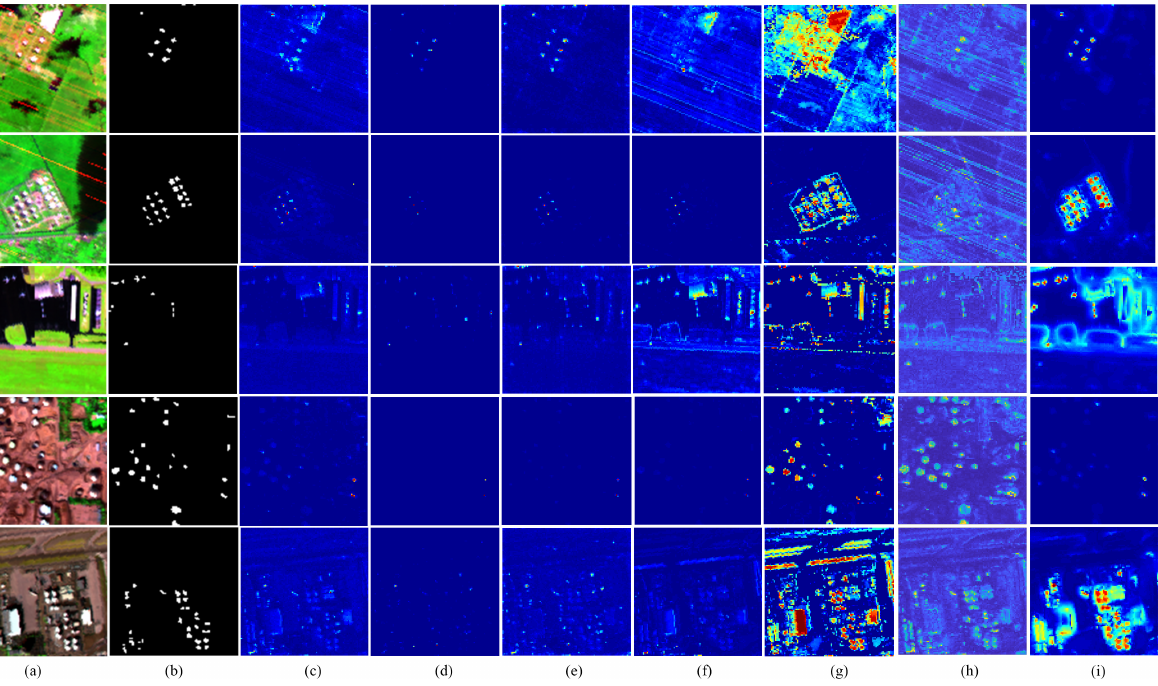
Figure 5. Detection maps of the compared AD methods. The sample mages from top to bottom are urban-1, urban-2, urban-3, urban-4, and urban-5, respectively. ( a ) Color composites of urban scene; ( b ) Reference map; ( c ) GRX; ( d ) LRX; ( e ) CRD; ( f ) LRASR; ( g ) ADLR; ( h ) KIFD; ( i )